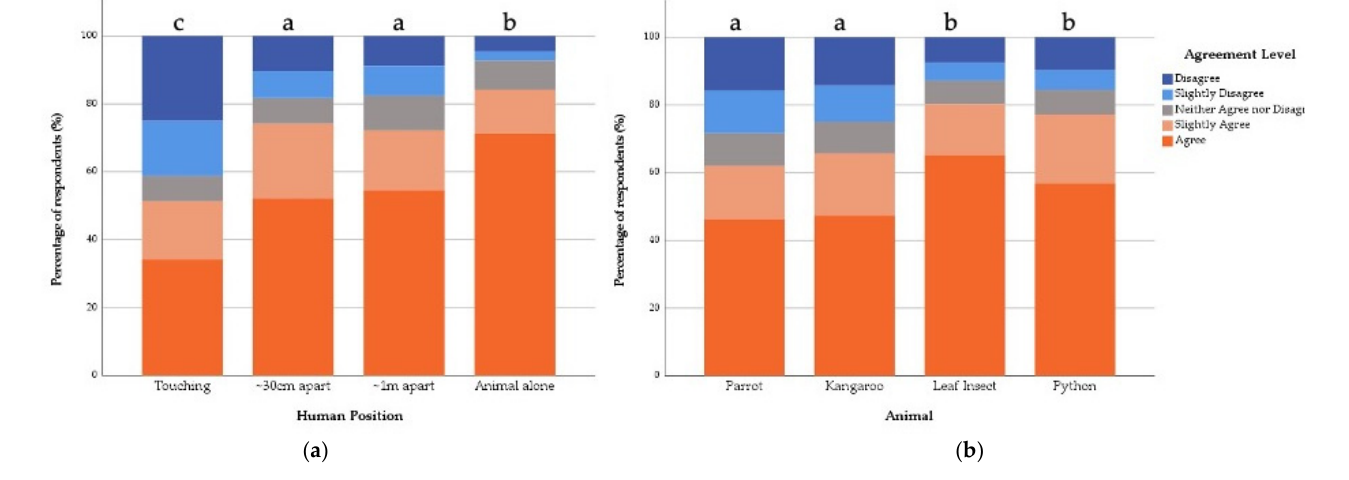
Animals 2022 , 11 , x FOR PEER REVIEW Significant results are highlighted in grey.